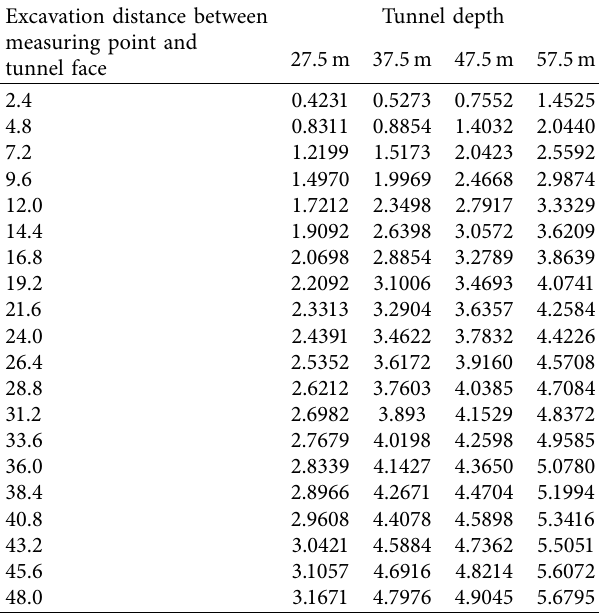
Table 4: Settlement of tunnel vaults with diferent buried depths (unit: cm).